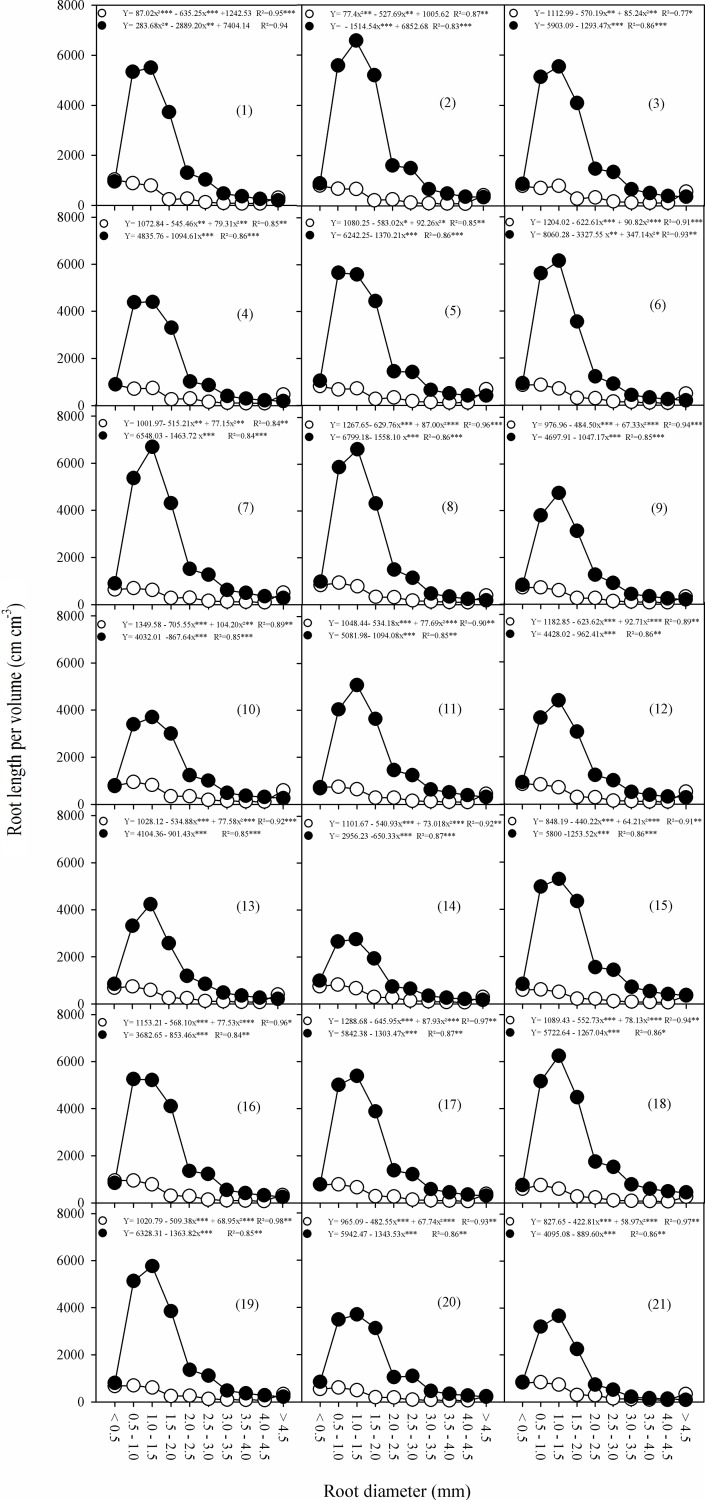
Root length per volume of cacao progenies, obtained from complete diallel crosses, under control (○) (predawn ΨWL between -0.1 and -0.5 MPa.) and drought (●) (predawn ΨWL between -2.0 and -2.5 MPa) conditions.